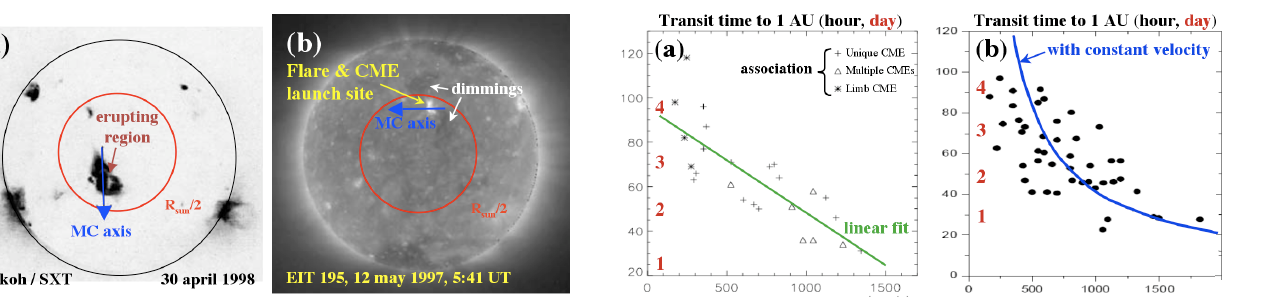
Fig. 3. The transit time of CMEs from the Sun to 1AU as a func- tion of their coronal velocity. (a) The abscissa is the leading edge velocity of halo CMEs observed by LASCO, so it is the velocity projected on the plane of sky (Zhang et al., 2003). (b) The abscissa is the radial velocity, V rad , measured from Helios 1 which was in quadrature with the Earth (within ± 30 ◦ ; Schwenn et al., 2005). The timing was corrected from Helios 1 to 1 AU by assuming a constant velocity. The comparison of the data to a model with constant ve- locity (curve) shows that ICMEs with a low initial coronal velocity are accelerated while fast ones are decelerated. The results of the two panels can be related to the result of Schwenn et al. (2005) on limb CMEs observed by LASCO: V rad ≈ 0 . 88 V exp (where V exp is the full lateral expansion velocity of the leading